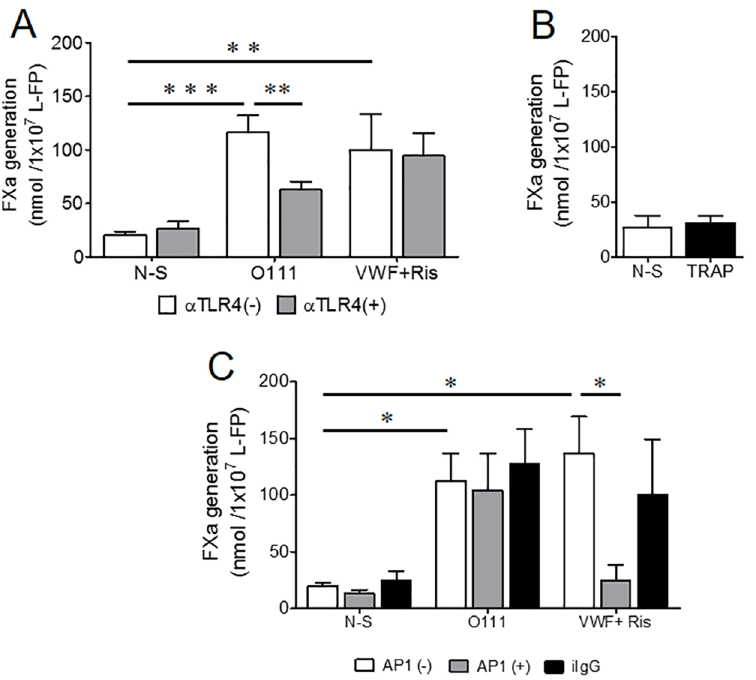
Fig 3. E . coli O111 induced platelet-dependent TF procoagulant activity, involving TLR4 activation. E . coli O111 increasedFXa generationcomparedto N-S platelets ( *** p= 0.0005, n = 8) in assays without externalsource of TF and phospholipids. The amount of FXa generated was not significantly different than that of platelets stimulated with VWF+Ris ( ** p= 0.004, n = 8). TLR4 inhibitionresulted in a ± -50%reductionin the generated FXa with strain O111 ( ** p= 0.004, n = 8), but did not influencethe FXa generatedby VWF+Ris activationof platelets (A). TRAP stimulated platelets did not generated FXa (B). Data analyzedby Paired t test, two-tailed. Pre-incubation of platelets with an inhibitory α -GPIb α MoAb (AP1) did not affect the FXa generatedby E . coli but instead, reduce significantly the FXa triggeredin plateletswith VWF+Ris ( * p = 0.03, n = 6) (C). Pre-incubation of platelets with a non-immune irrelevantIgG did not inducedsignificantchangesin FXa generation when stimulatedwith bacteriaor VWF+Ris (n = 4) (C). Data were analyzedwith Wilcoxon signedrank test, two